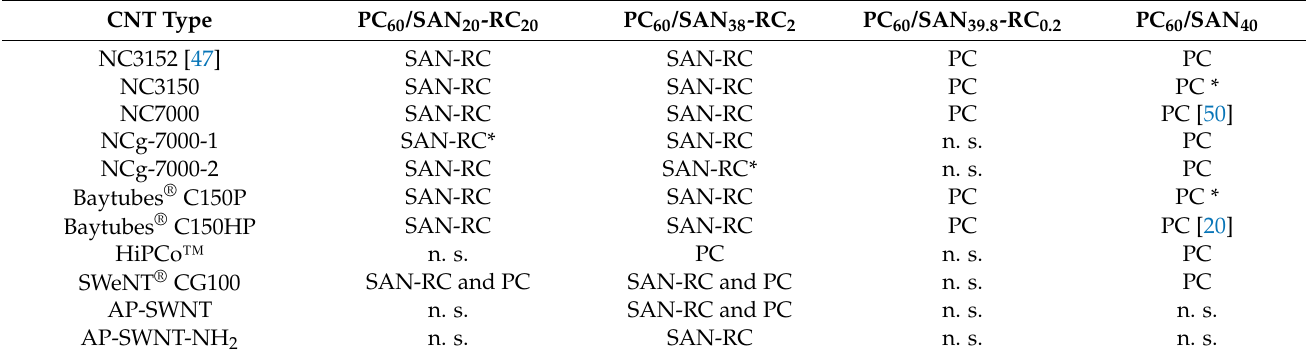
Table 1. Assignment of which blend component the various CNTs are localized in when 0.5 wt.% CNTs are added in a one-step melt blending